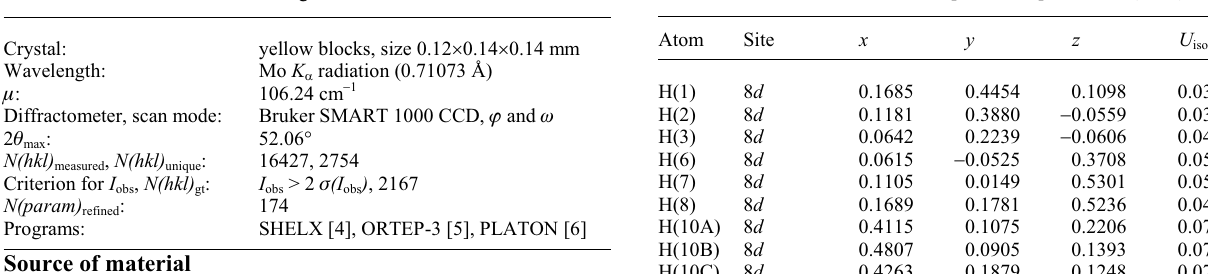
Table 1. Data collection and handling. Table 2. Atomic coordinates and displacement parameters (in Å 2 )